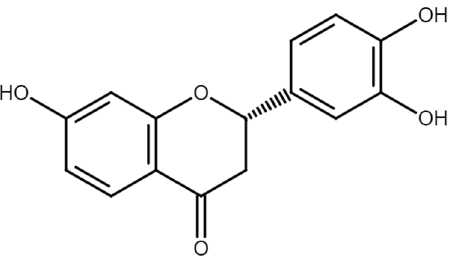
Figure 4. Structure of the biotransformation product butin.